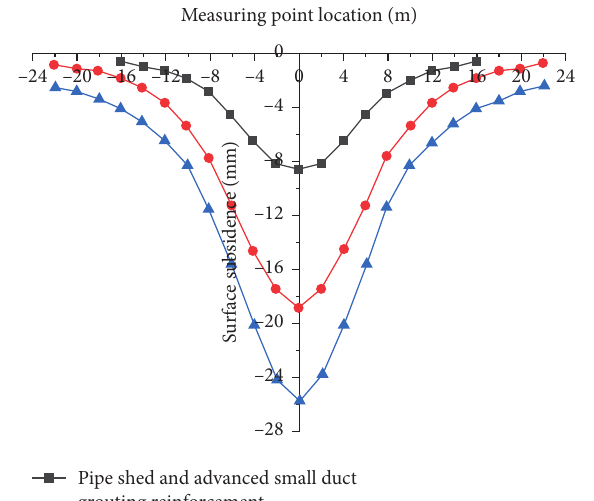
Figure 11: Distribution of surface settlement trough after the excavation of core soil.